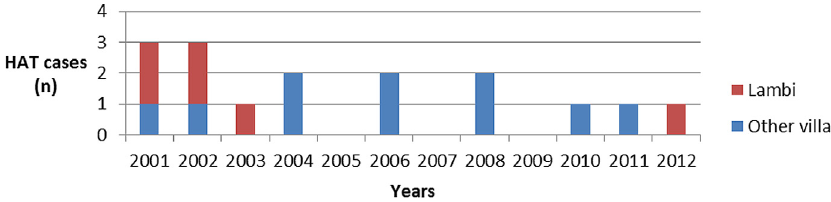
Figure 1. HAT cases diagnosed between 2001 and 2012 in the focus of